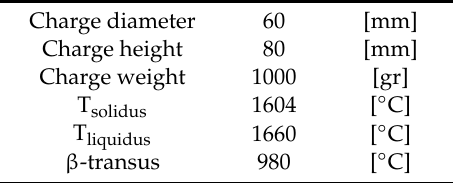
Table 1. Physical properties of Ti-6Al-4V charge.